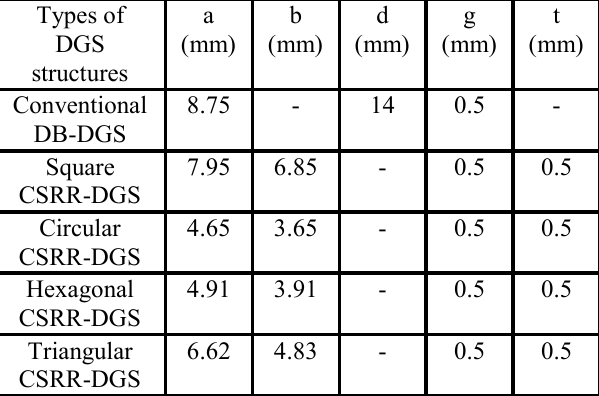
Table 1. Dimensions of various DGS structures Types of